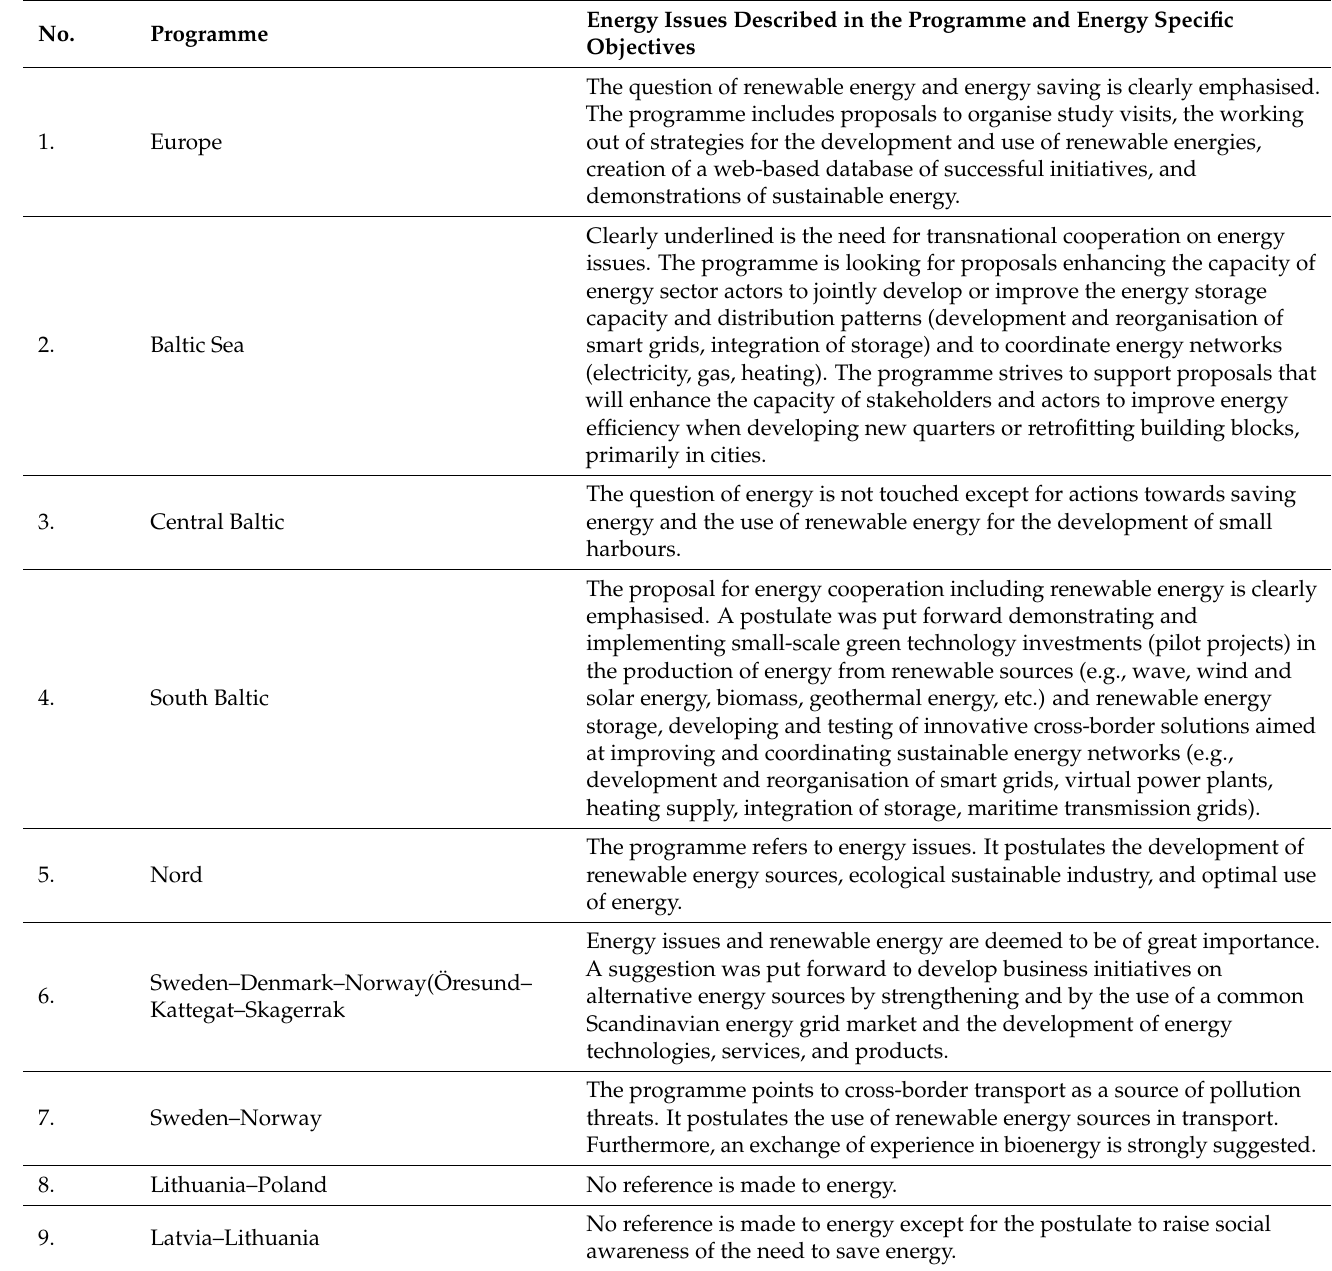
Table 3. Energy issues in ETC programmes for BSR in the period